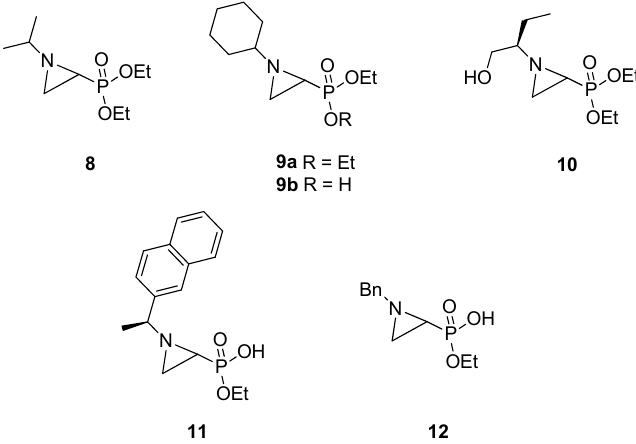
Figure 2. Structures of biologically active aziridine-2-phosphonates.